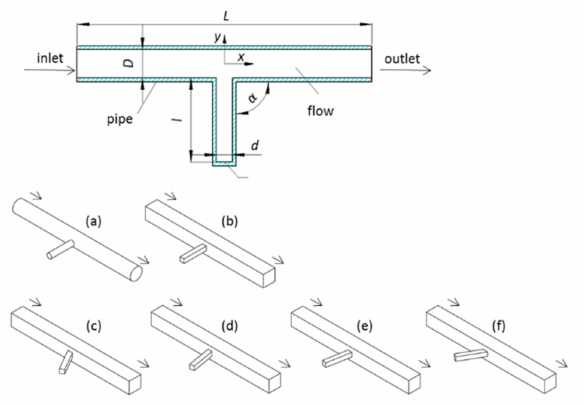
Figure 3. Geometry model schematic of pipe shapes, ( a ) case 1: circular pipe, α = 90 ◦ , ( b ) case 2: square pipe, α = 90 ◦ , ( c ) case 3: square pipe, α = 60 ◦ , ( d ) case 4: square pipe, α = 80 ◦ , ( e ) case 5: square pipe, α = 100 ◦ , and ( f ) case 6: square pipe, α = 120 ◦ .